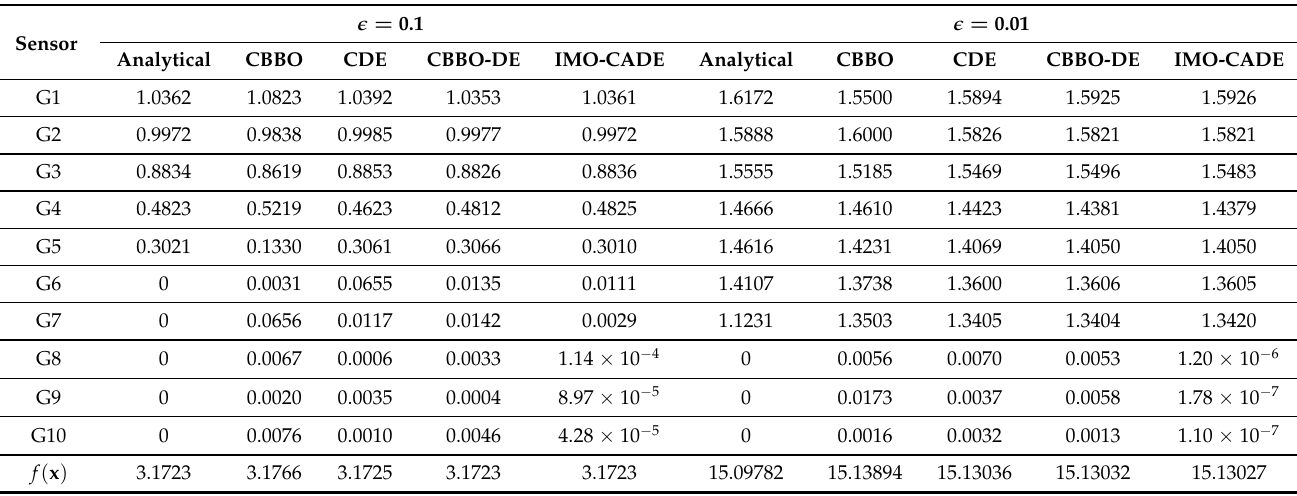
Table 7. Comparison between analytical and different numerical methods to gain allocation with K = 10, γ 0 = 10 dB, and ρ = 0.